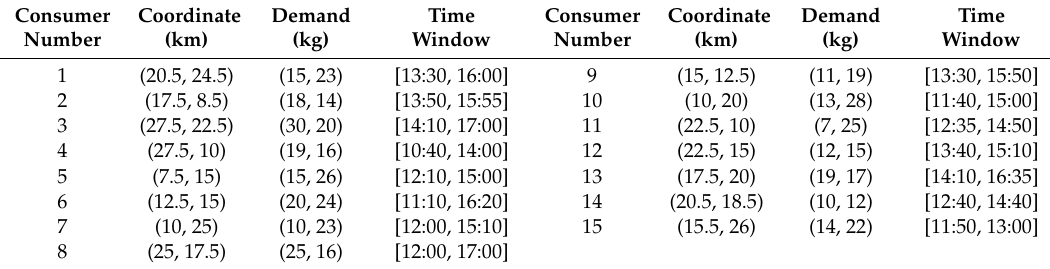
Figure 3. Schematic diagram of spatial coordinates. Table 1. The consumer information.